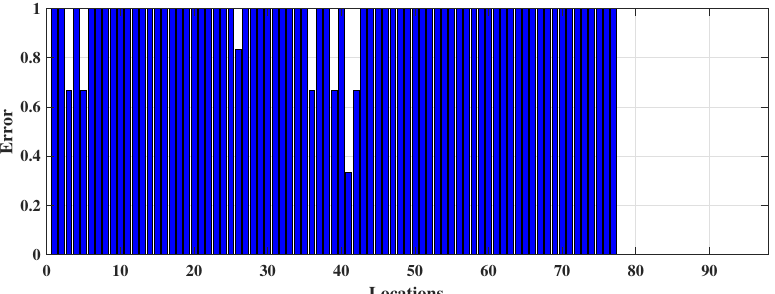
Figure 9. The occurrence of error in each coordinate from SVM RBF classification during online phase.